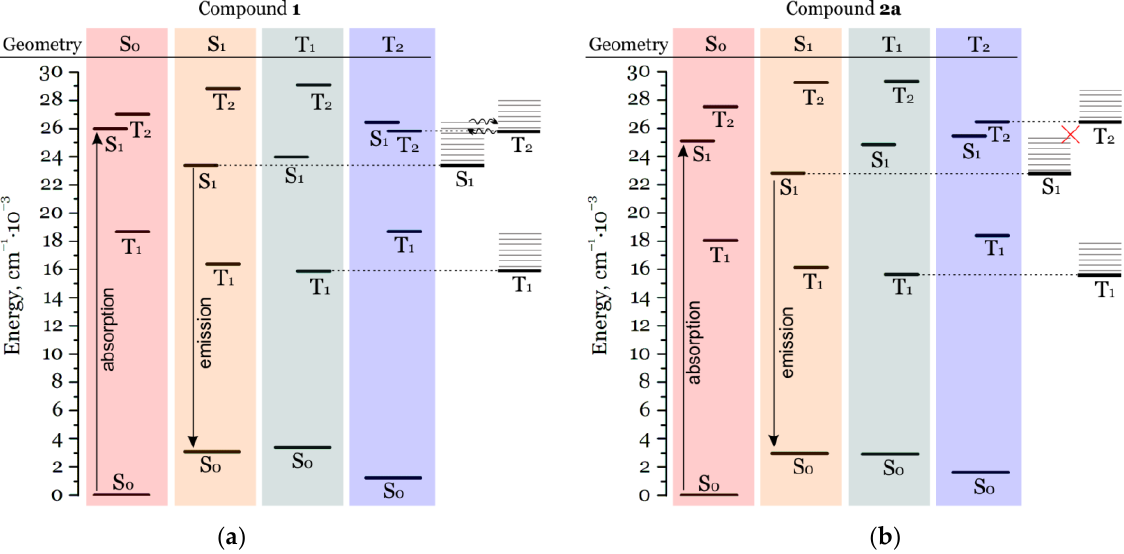
Figure 6. Representation of energy levels for different geometry states (S o , S 1 , T 1 , and T 2 ) of com- pounds 1 ( a ) and 2a,b regarding the example of 2a ( b ) in the energy range from 0 to 30 × 10 3 cm – 1 .